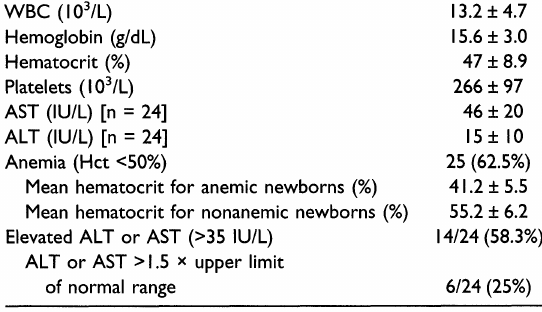
TABLE 4. Newborn laboratory values